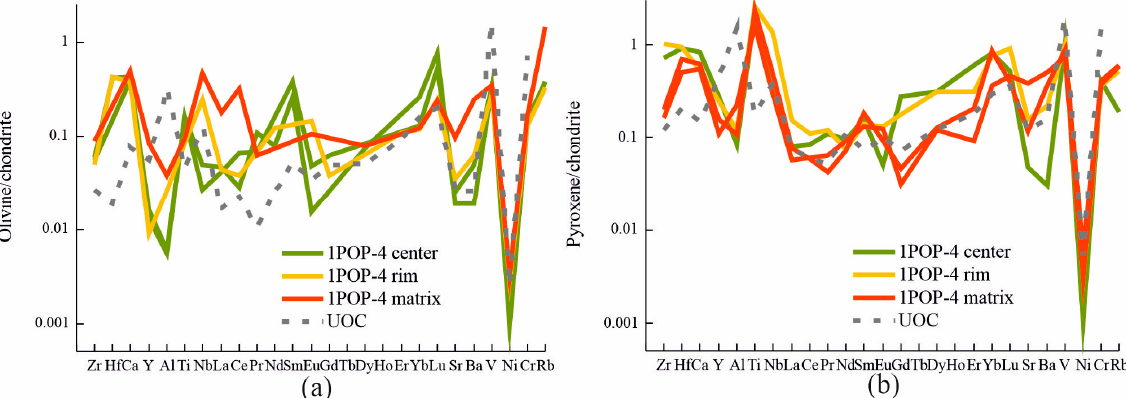
Figure 6. CI chondrite-normalized trace element patterns of olivine ( a ) and pyroxene ( b ) of 1POP-4 chondrule and matrix.